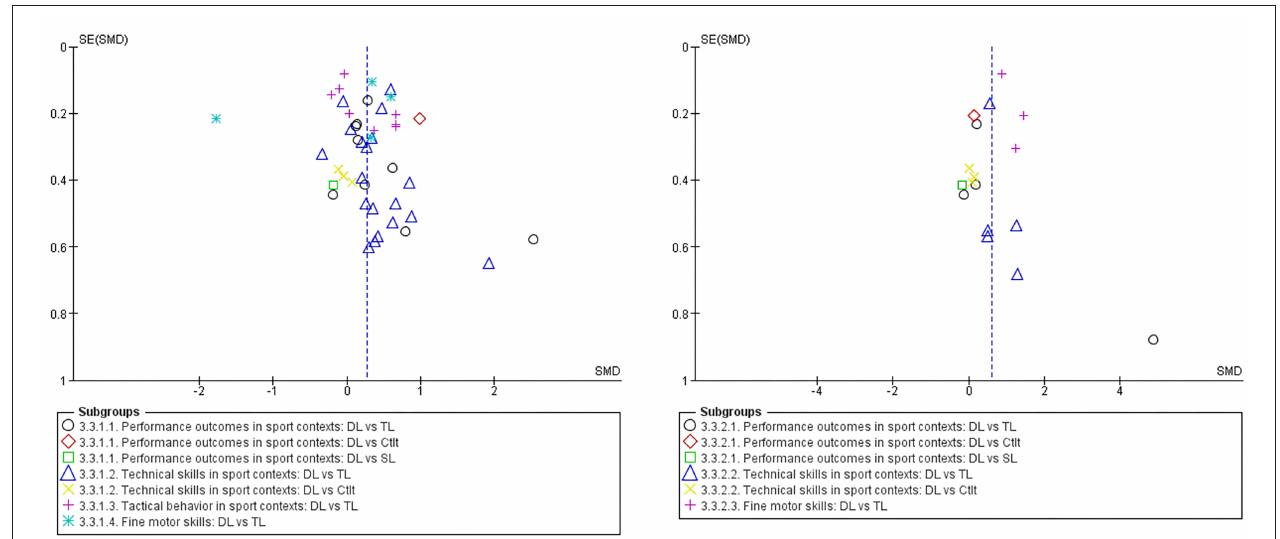
FIGURE 4 | Funnel plots of the effect sizes of the acquisition phase (left) and learning phase (right). Vertical dashed line shows the overall effect size. DL, differential learning; TL, traditional learning; CtIt, contextual interference; SL, structural